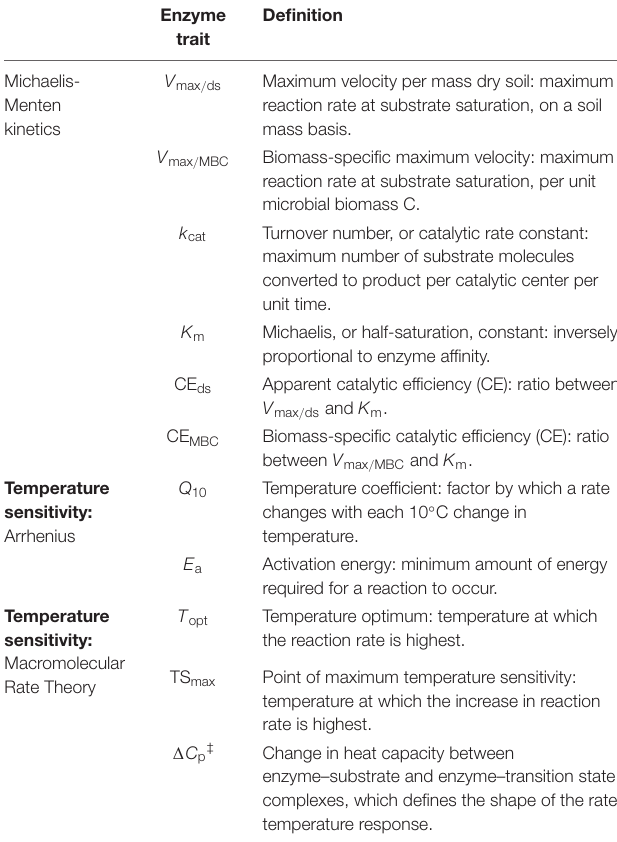
TABLE 2 | Enzyme trait abbreviations and definitions used this study. Enzyme